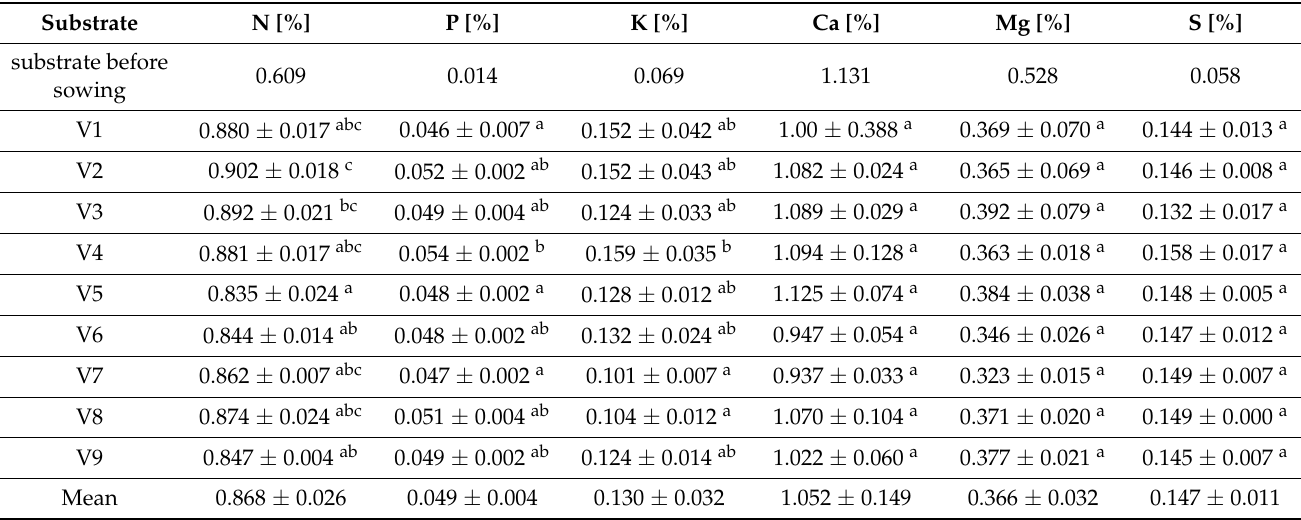
Table 2. Percentage of macroelements in the substrate before sowing and after growing (V1–V9) the seedlings for each density variant ( ± SD). The letters a, b and c indicate significant differences between the means.